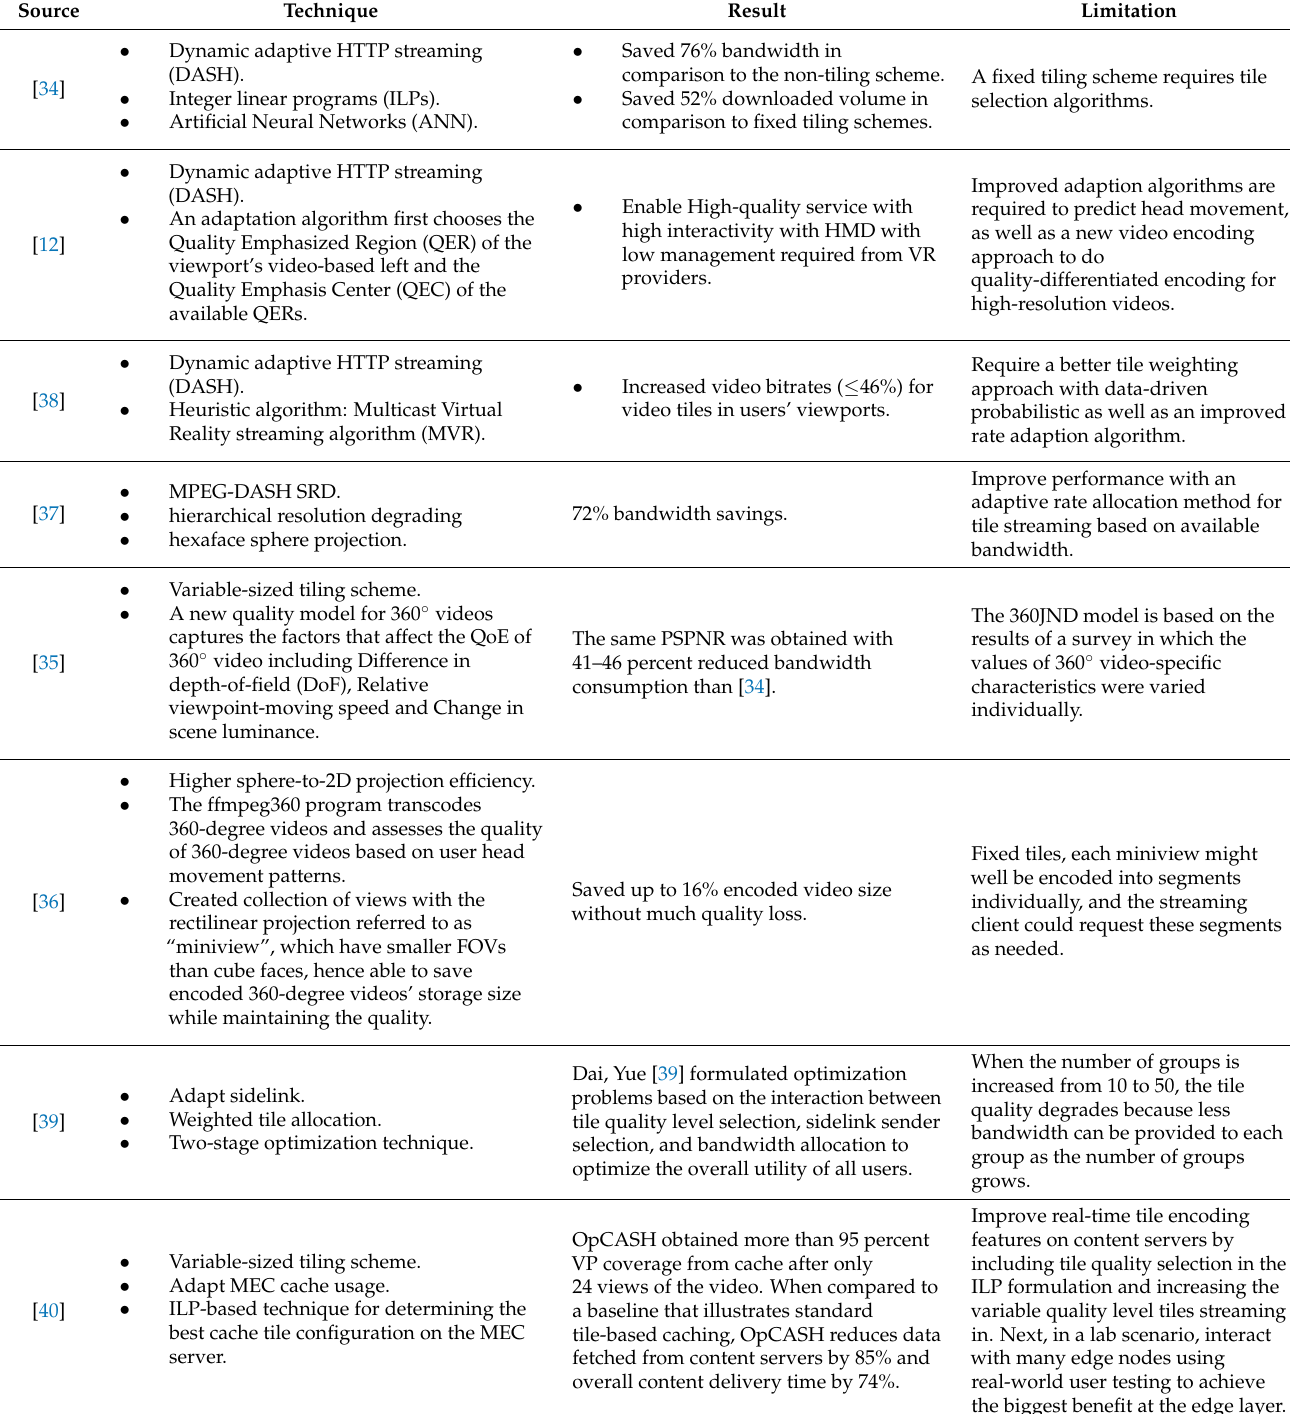
Table 3. Comparison of existing tiling